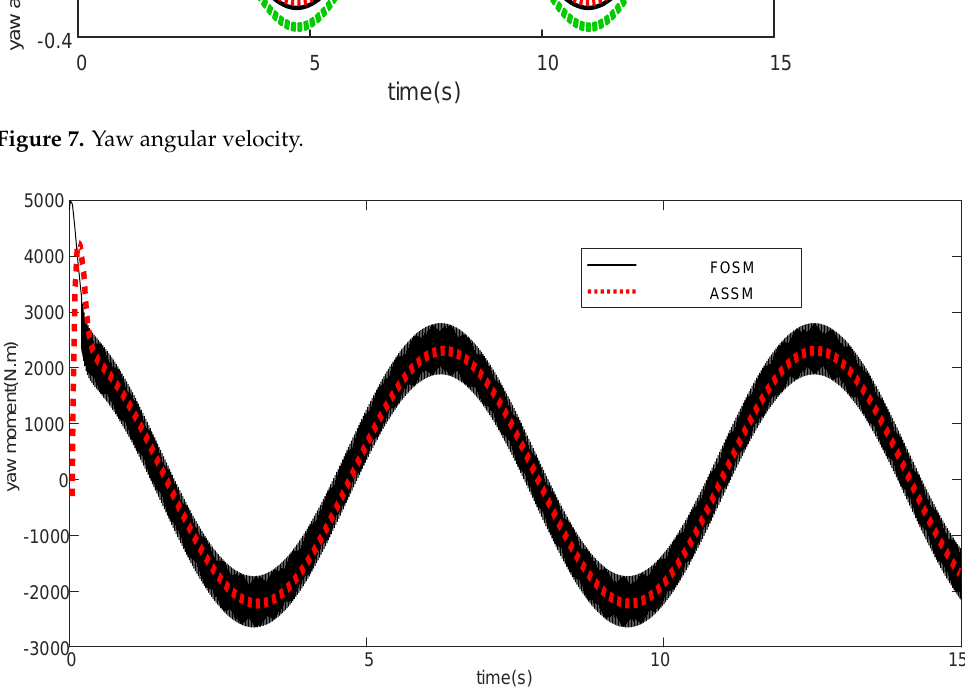
Figure 8. Yaw moment. 4.2. Slalom Condition 1: The Uniform Road Adhesion Coefficient μ = 0.3, and the Vehicle Speed Is 65 km/h